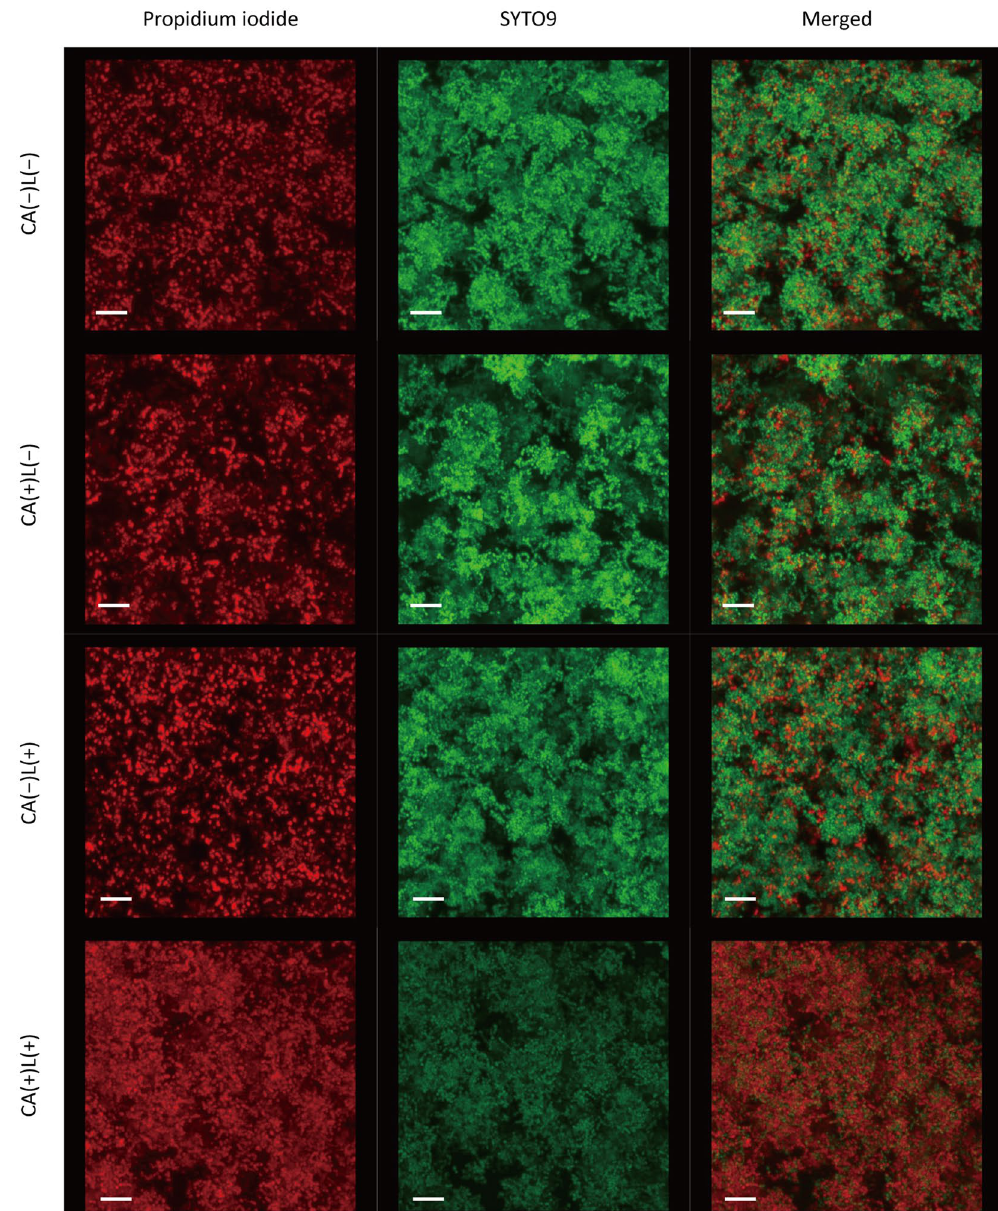
Figure 2. Representative confocal laser scanning microscopic images of Streptococcus mutans biofilm treated with photo-irradiated caffeic acid (CA) solution. CA( − )L( − ): Treatment with pure water in a light-shielding box, CA( + )L( − ): Treatment with CA in a light-shielding box, CA( − )L( + ): LED irradiation of sample in pure water, CA( + )L( + ): LED irradiation of sample in CA. CA was used at 1 mg/mL and LED irradiation at 385 nm was performed at an irradiance of 2000 mW/cm 2 . Each treatment was performed for 4 min. Dead bacteria were stained by only propidium iodide (red), whereas both dead and living bacteria were stained by SYTO9 (green). Scale bars in each image represent 5 µ